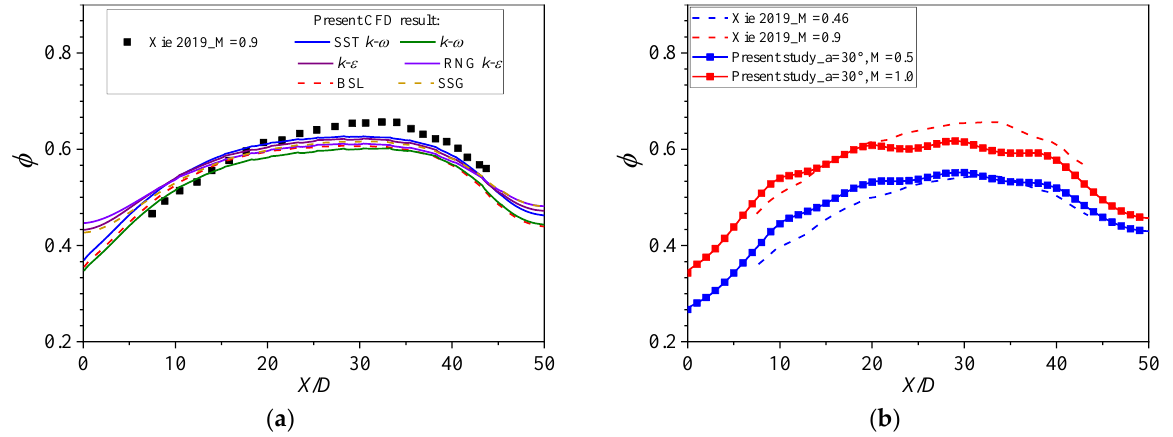
Figure 2. Comparison of laterally averaged overall cooling effectiveness ( a ) between CFD results of different turbulence models based on the literature model [30] and literature experimental data at M = 0.9 [30] and ( b ) between the present results at α = 30° and experimental data [30] at different M .